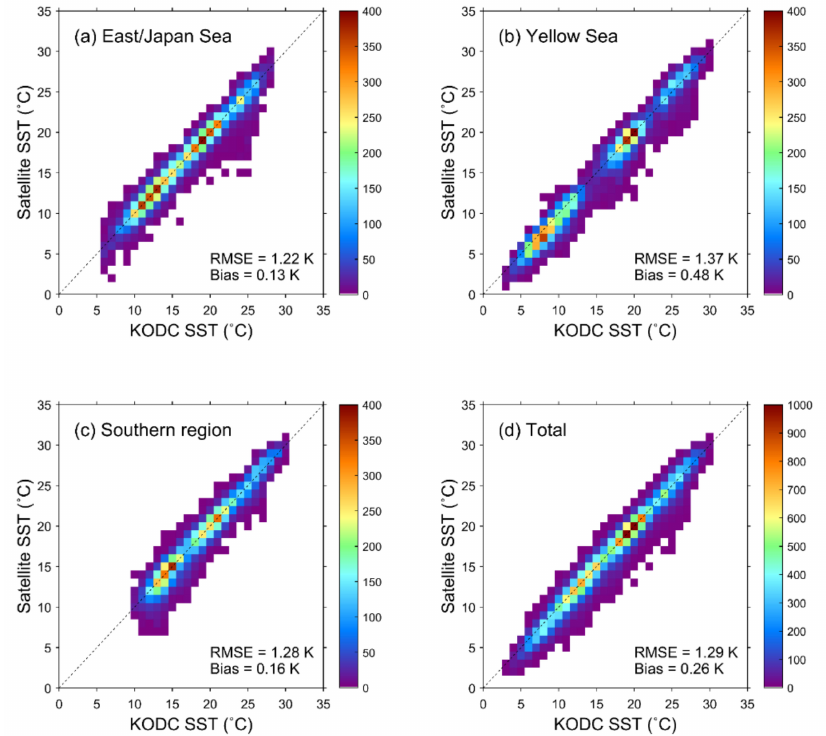
Figure 4. Comparison between satellite SST and in situ SSTs of KODC observation stations, where the color represents the number density of the